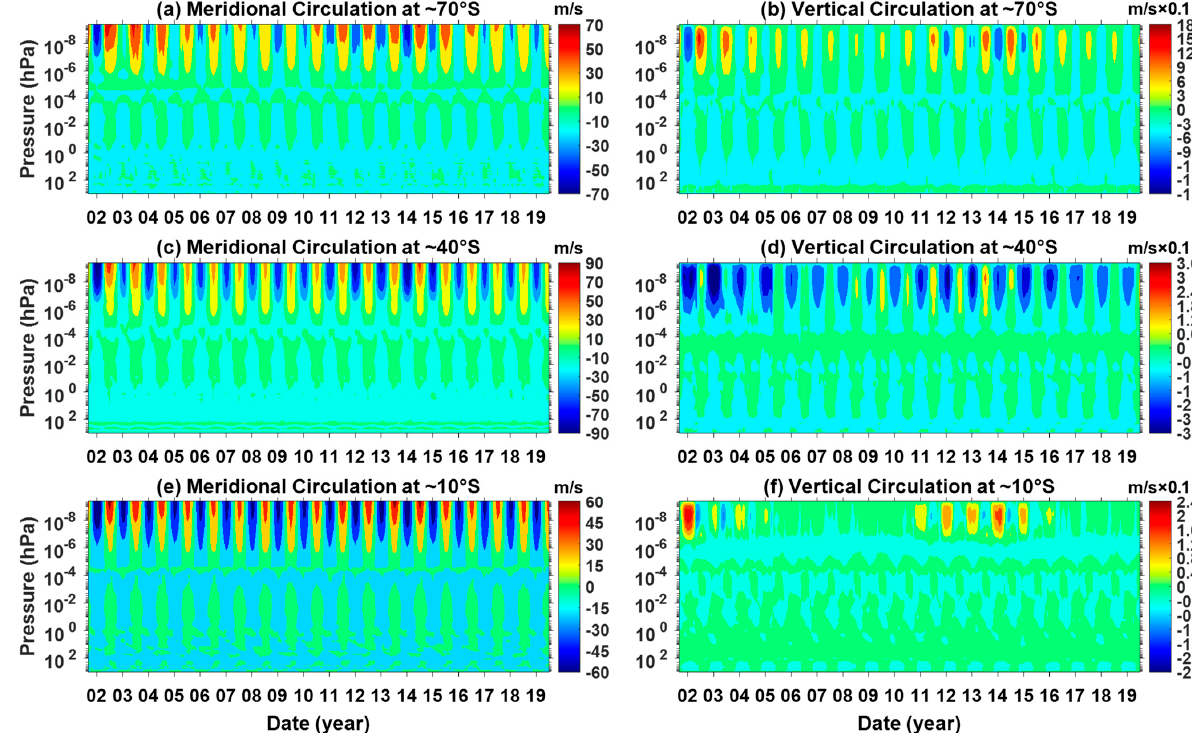
Figure 4. Temporal variations in the ( a , c , e , g ) meridional circulation and ( b , d , f , h ) vertical circulation at ( a , b ) ~50 km, ( c , d ) ~90 km, ( e , f ) ~130 km, and ( g , h ) ~170 km from 2002 to 2019.